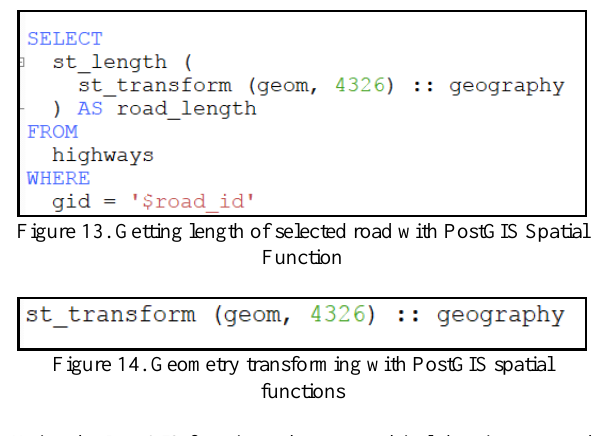
Figure 14. Geometry transforming with PostGIS spatial functions